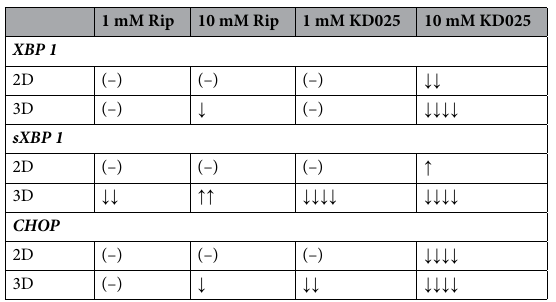
Table 1. Summary of the effects of ROCK 1 and ROCK 2 on the physical properties of 3D human corneal stroma fibroblasts (HCSFs) spheroids and gene expression of 2D and 3D cultured HCSFs. Rip: ripasudil, 2D: two-dimension culture, 3D: three-dimension culture, COL : collagen, FN : fibronectin, TIMP : tissue inhibitor of metalloproteinase, MMP : matrix metalloproteinase, protein kinase RNA-like endoplasmic reticulum kinase (PERK), activating transcription factor 6 (ATF6) and the inositol-requiring enzyme 1 (IRE1), and their downstream factors including the glucose regulator protein (GRP)78, GRP94, the X-box binding protein-1 (XBP1), spliced XBP1 (sXBP1) and CCAAT/enhancer-binding protein homologous protein (CHOP), (–): no significant change, ↑ : significant increase (p < 0.05), ↑↑ : significant increase (p < 0.01), ↑↑↑ : significant increase (p < 0.005), ↓ : significant decrease (p < 0.05), ↓↓ : significant decrease (p < 0.01), ↓↓↓ : significant decrease (p <